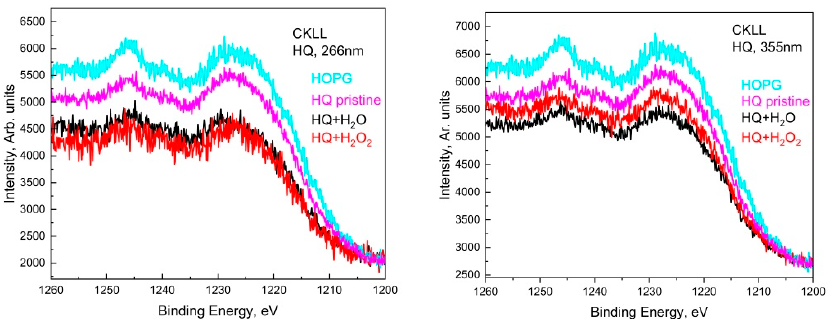
Figure 3. Auger spectra of HQ+H 2 O and HQ+H 2 O 2 sediments for both wavelengths, 266 nm and 355 nm, compared to HQ pristine and HOPG.